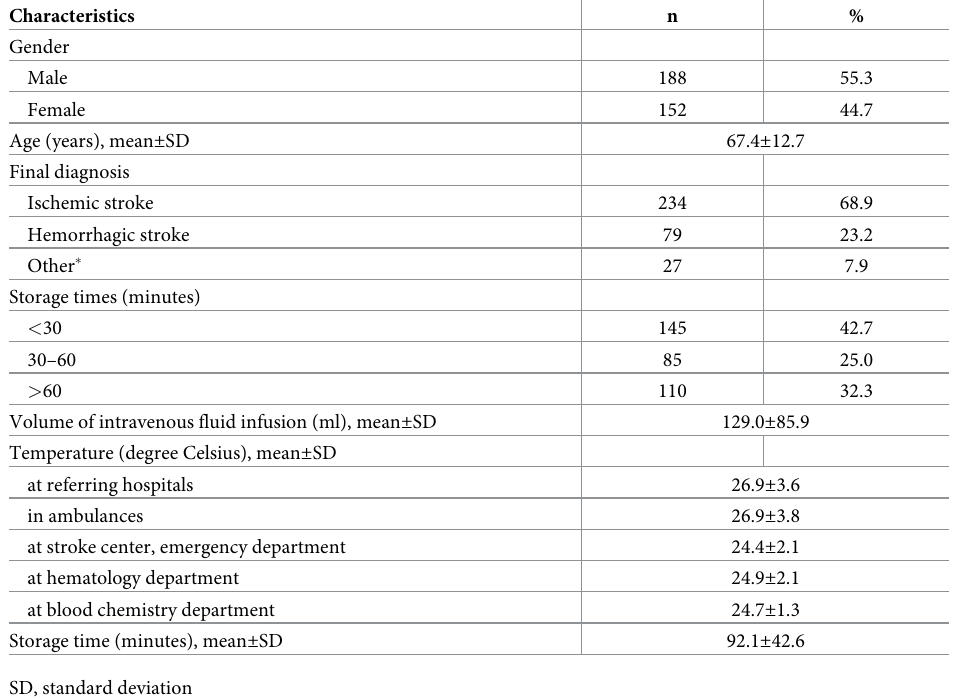
Table 1. Baseline characteristics of patients with suspected acute stroke (n =